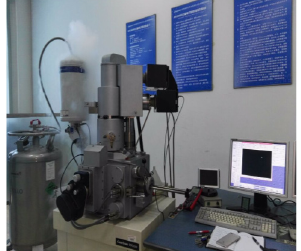
Figure 2. Scanning electron spectrometer.